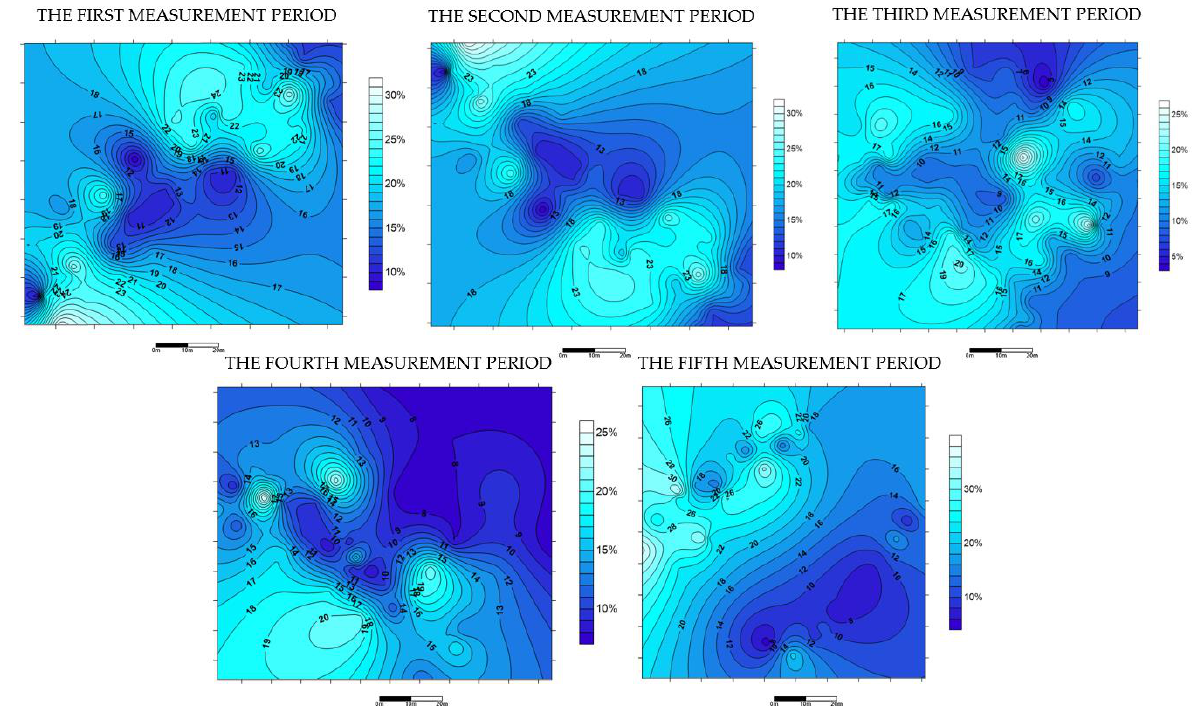
Figure 6. Maps of the soil moisture in the test area for different measurement periods.